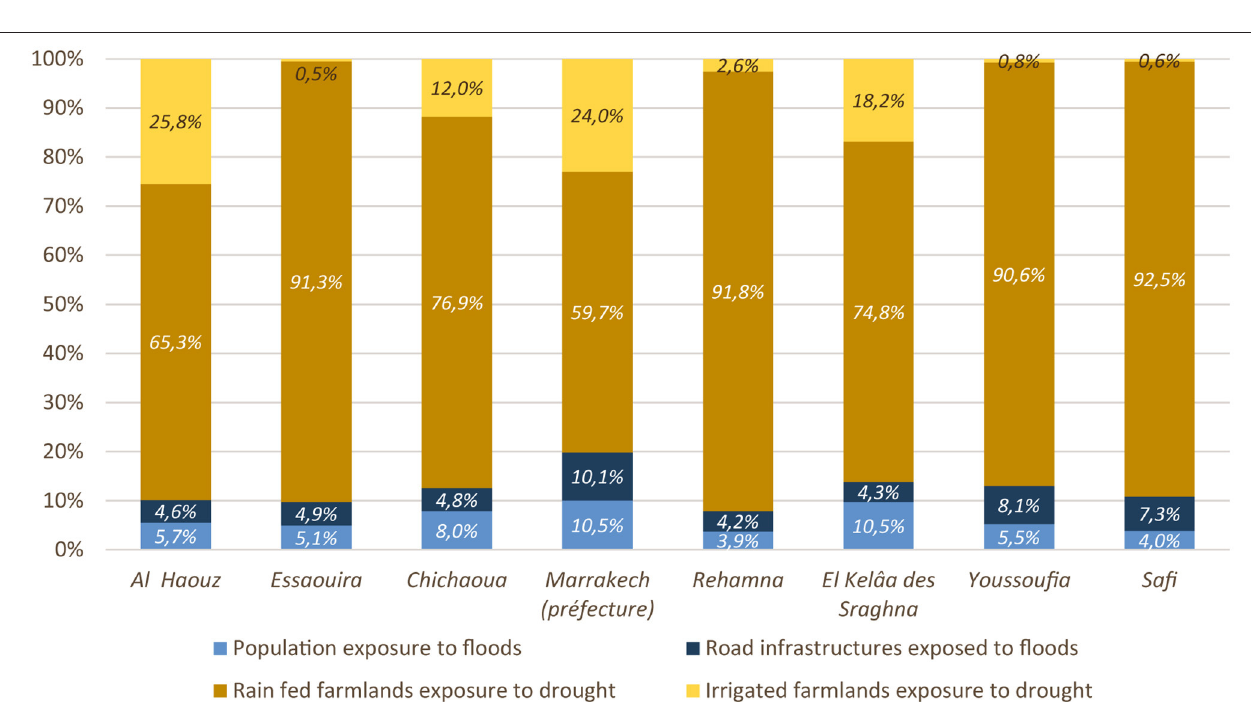
FIGURE 4 | Number of municipalities per combination of single-risks combination (aggregated at the provincial level).